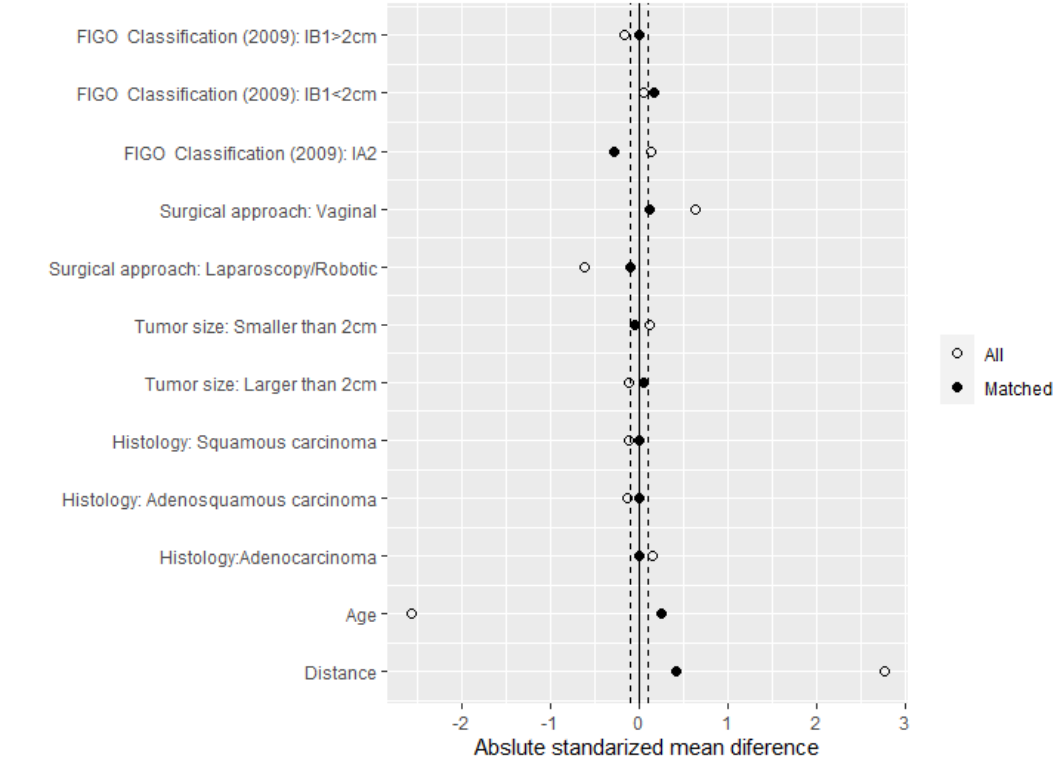
Figure 1. Distribution of the variable age at diagnosis in both treatment groups.